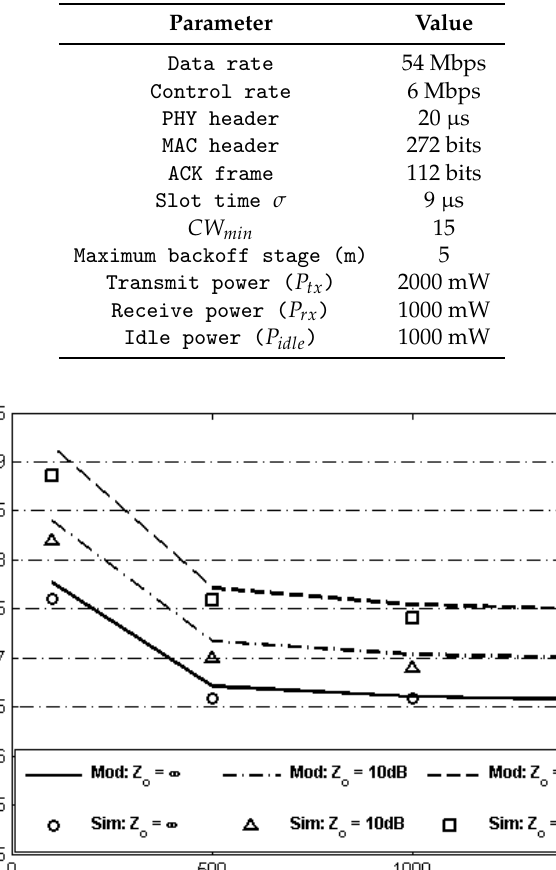
Table 2. Parameters for experiments.